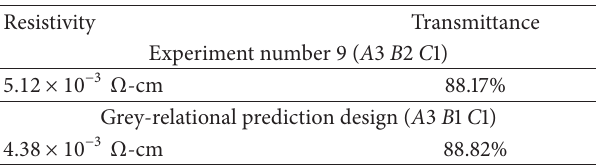
Table 6: Results of confirmation test for multiple performance characteristics of ZnO thin